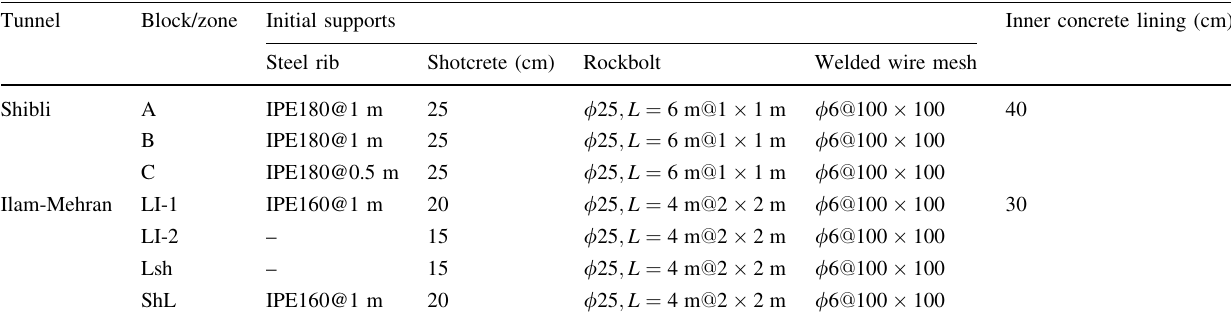
Table 1 Initial and secondary support systems Tunnel